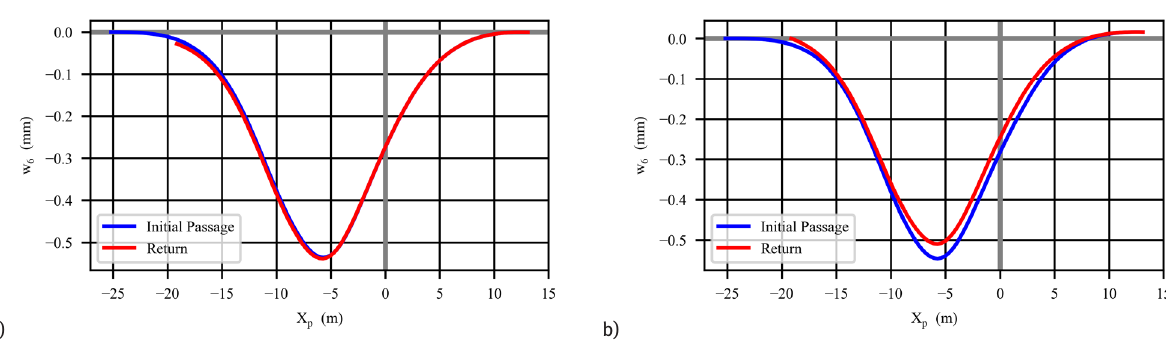
Figure 11: Vertical displacement of point No. 6 during consecutive vehicle crossings: without shell ballasting (a) and with ballasting